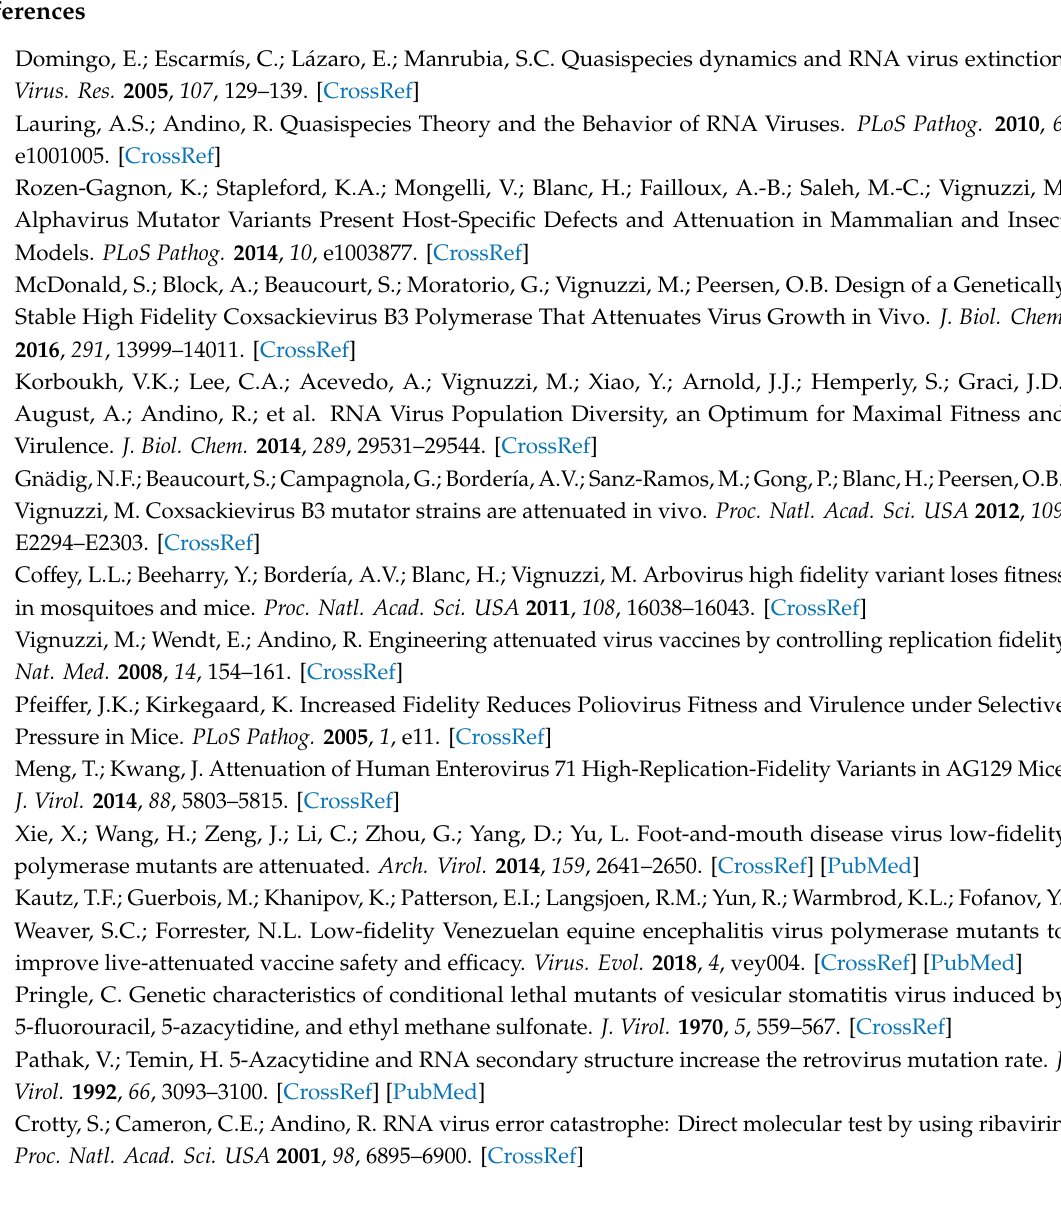
Figure S1: Mutation frequency of VEEV TC-83 E3 56-59 mutants at coding regions across the genome, Table S1: Average reads per sample for Analysis A, Table S2: Most frequent mutations for each sample for Analysis